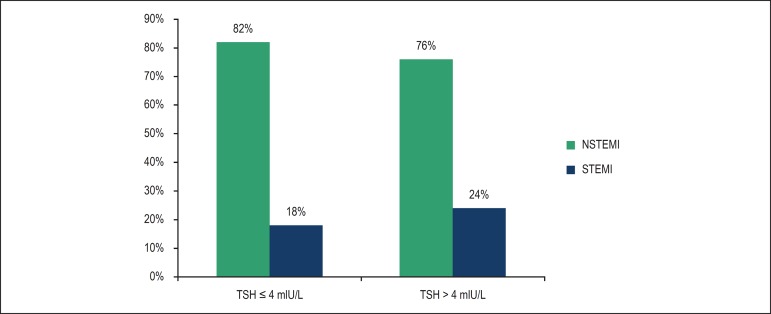
Classification of ACS according to TSH levels. NSTEMI: Non-ST-elevation
myocardial infarction; STEMI: ST-elevation myocardial infarction; TSH:
thyrotropin.